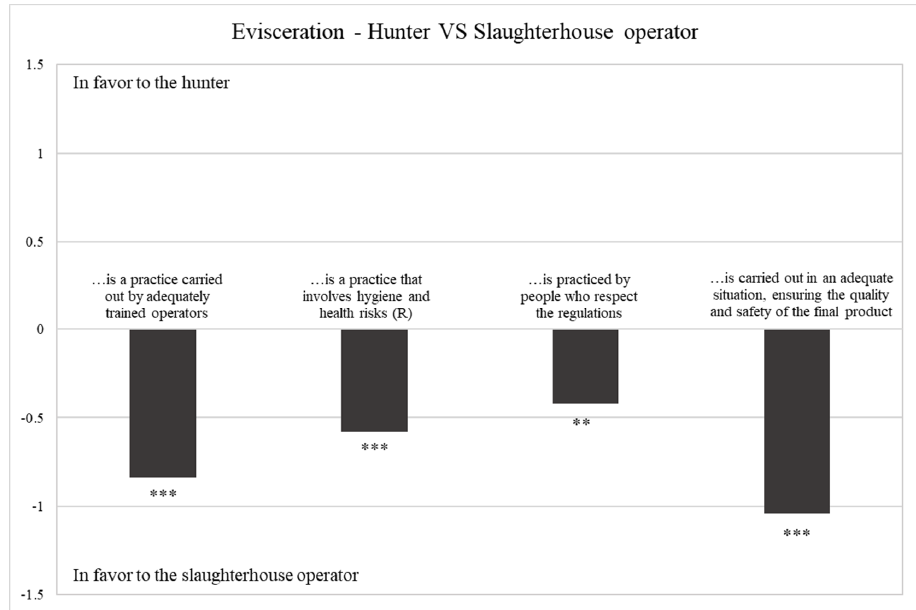
Figure 3. Difference between perceptions towards hunters vs. slaughterhouse operator. *** Sign. < 0.001; ** Sign. < 0.010; * Sign. < 0.050; n.s. not significant .